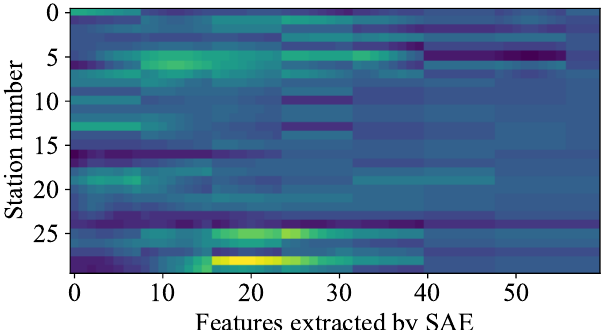
Figure 16. An example of atmospheric electric field data